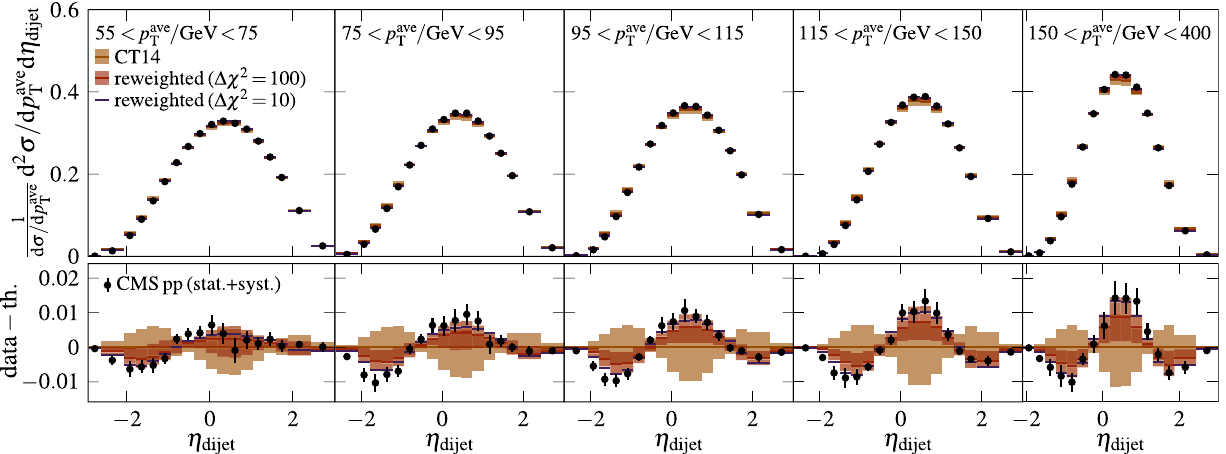
Fig. 4 Upper panels: the impact of reweighting on CT14 predic- tions of pp dijet spectra. The original predictions are shown in orange and the results obtained with quadratic–quadratic reweighting using Δχ 2 = 100areshowninred.Inbothcasesthesolidlinescorresponding